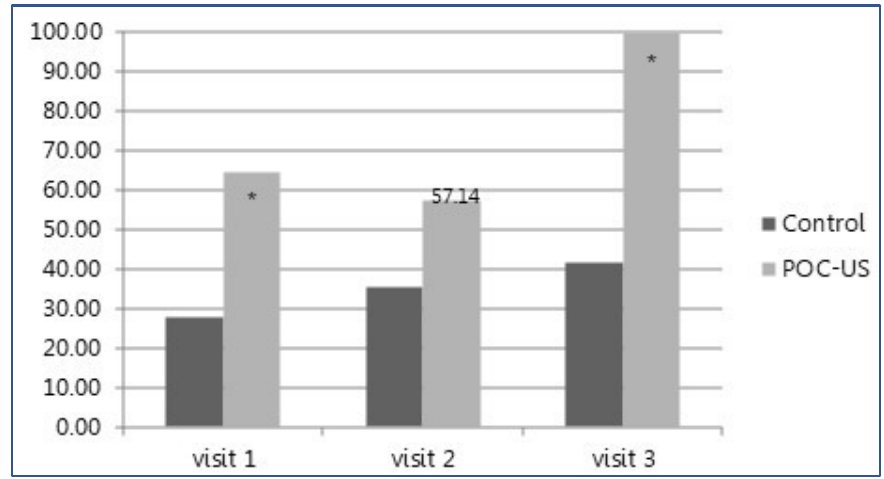
Figure 2. Management change rate per visit. Management change by treatment group presented as percentage of patients exposed to a change. * refers to a statistically significant difference, p value < 0.05. Table 3. Models for management change rate factors among two study